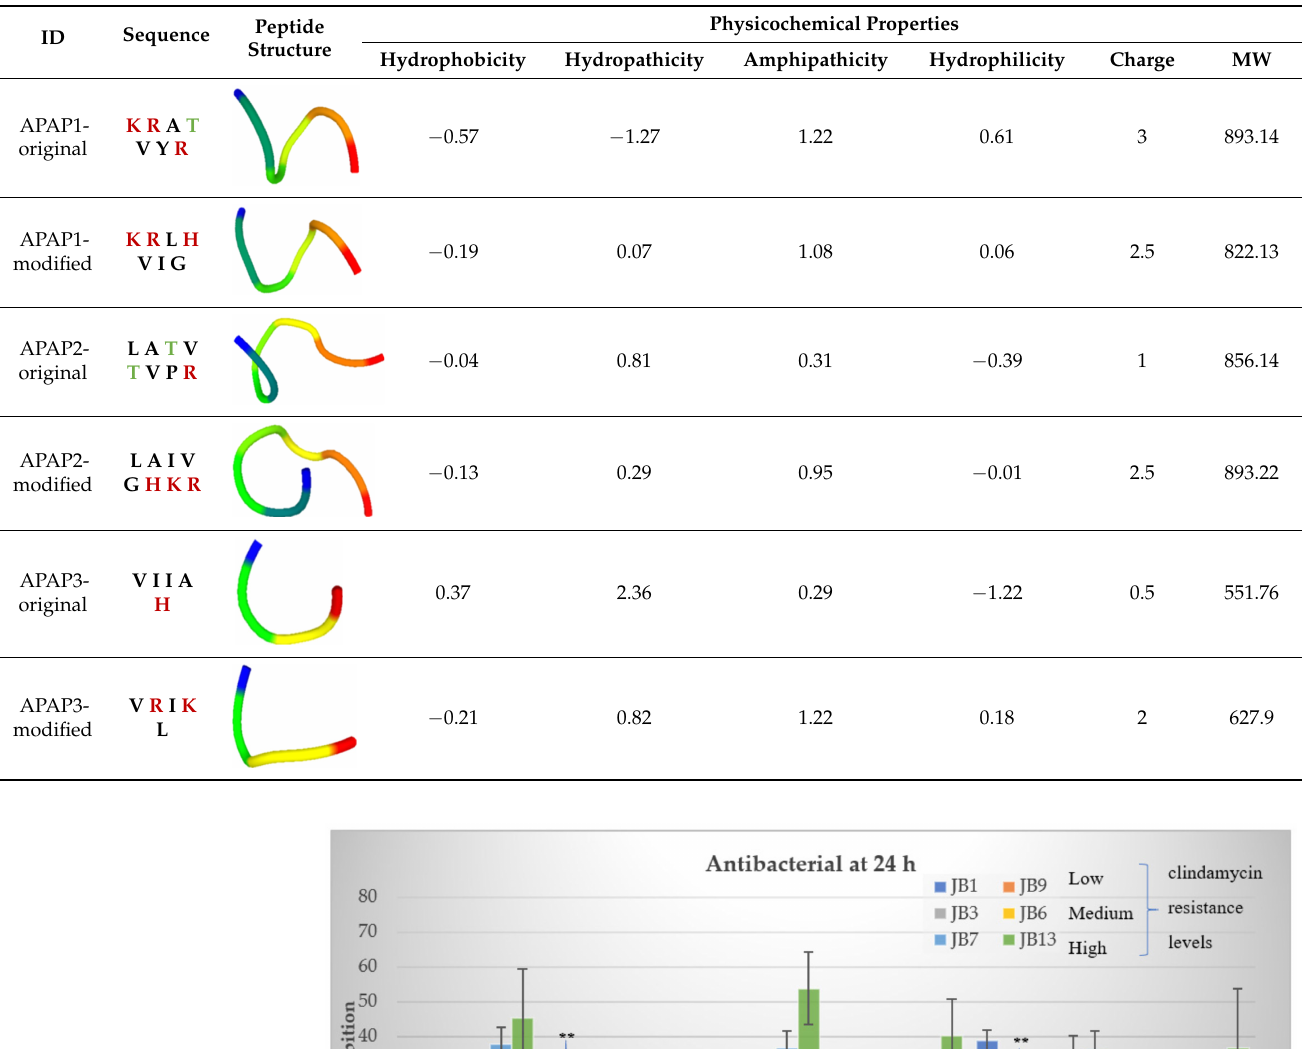
Table 2. Selected and modified antibacterial peptide sequences, structures, and physiochemical properties.